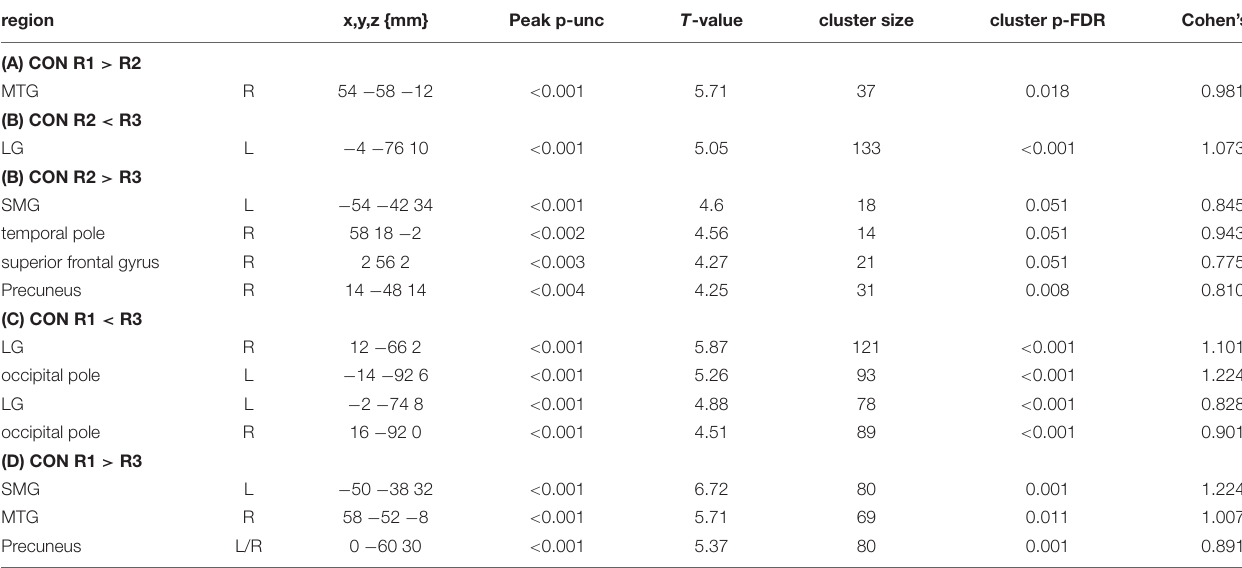
TABLE 3 | Consolidation-specific resting-state activity. region x,y,z {mm} Peak p-unc T -value cluster size cluster p-FDR Cohen’s